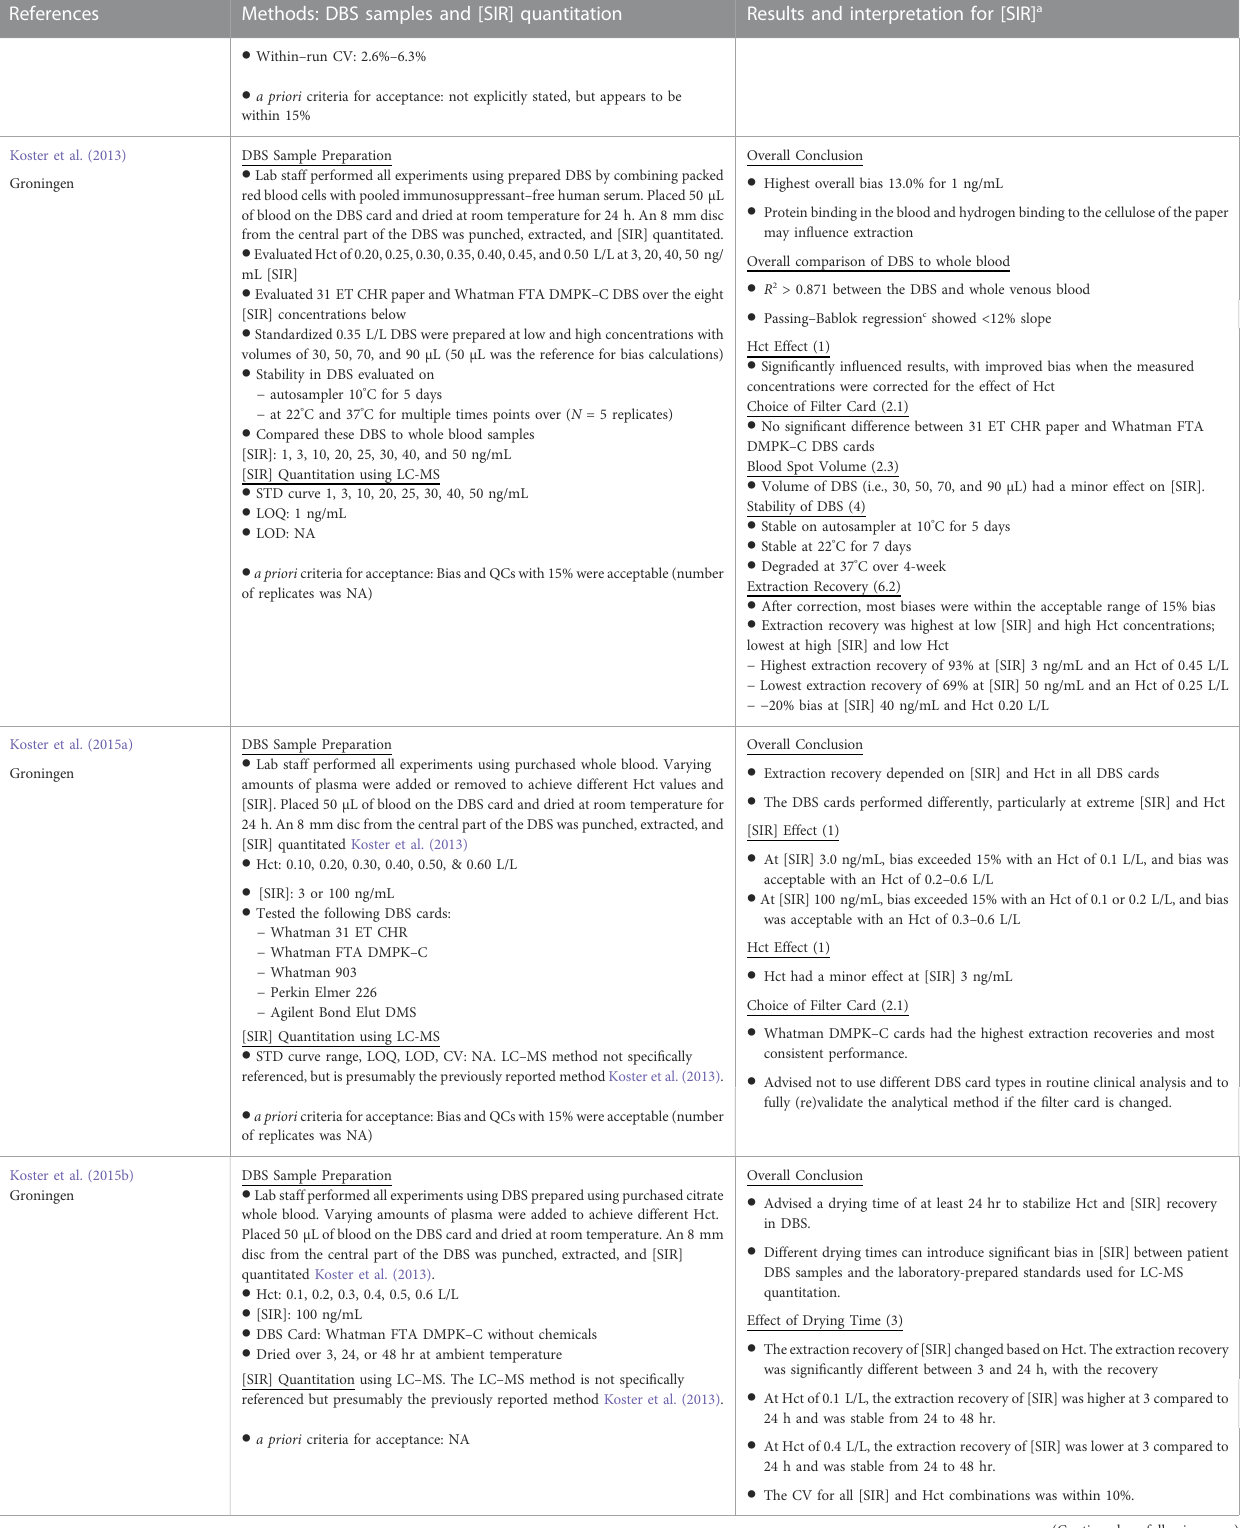
Proteinbindinginthebloodandhydrogenbindingtothecelluloseofthepaper may in fl uence extraction Overall comparison of DBS to whole blood (cid:129) R 2 > 0.871 between the DBS and whole venous blood